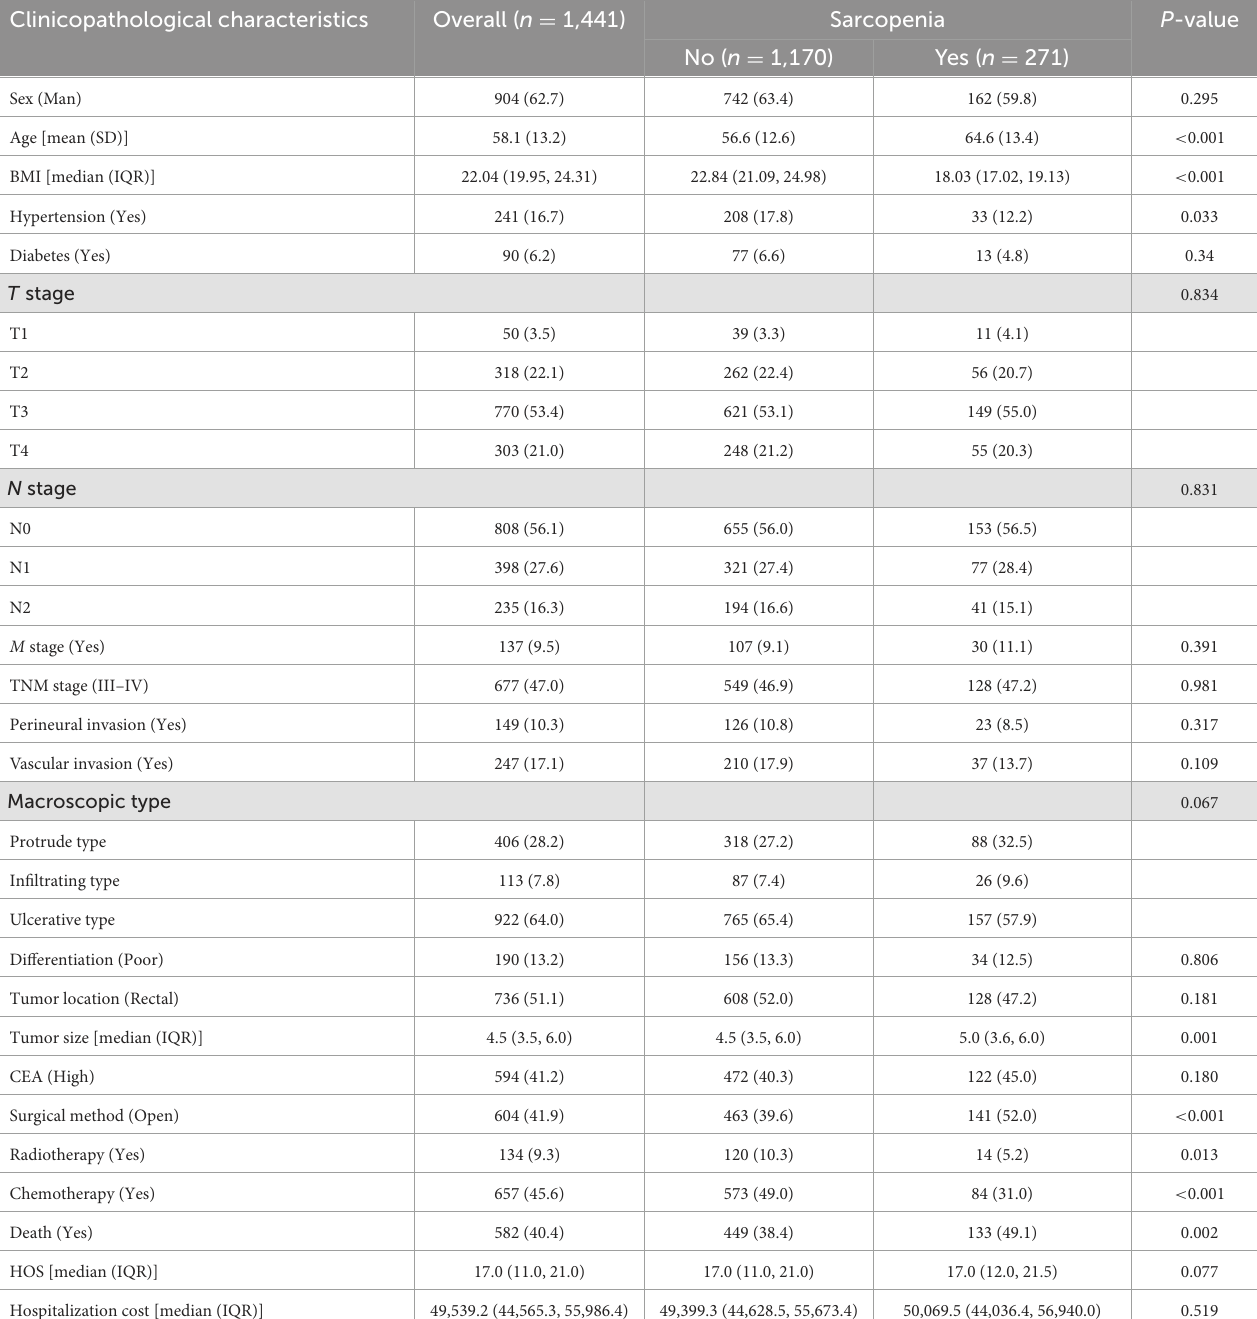
TABLE 1 The relationships between the sarcopenia and clinicopathological factors of CRC